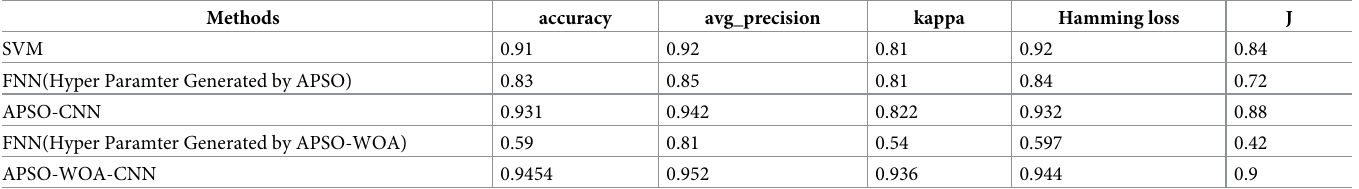
Table 6. Results of all algorithms according to evaluation matrices.